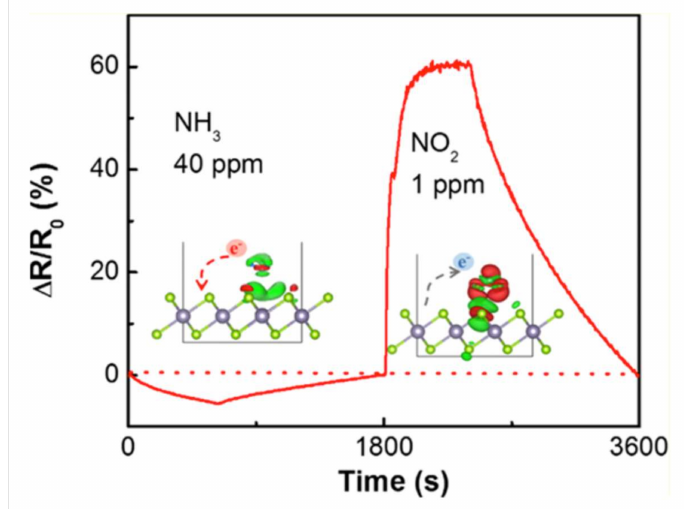
Figure 10. Dynamic response-recovery curve for NO 2 (1 ppm) and NH 3 (40 ppm). The inset depicts that electronic charge transfer occurs from SnSe 2 to NO 2 , while the opposite charge transfer exists in the case of NH 3 , congruently with experimental findings on electrical tests. Reproduced with permission from